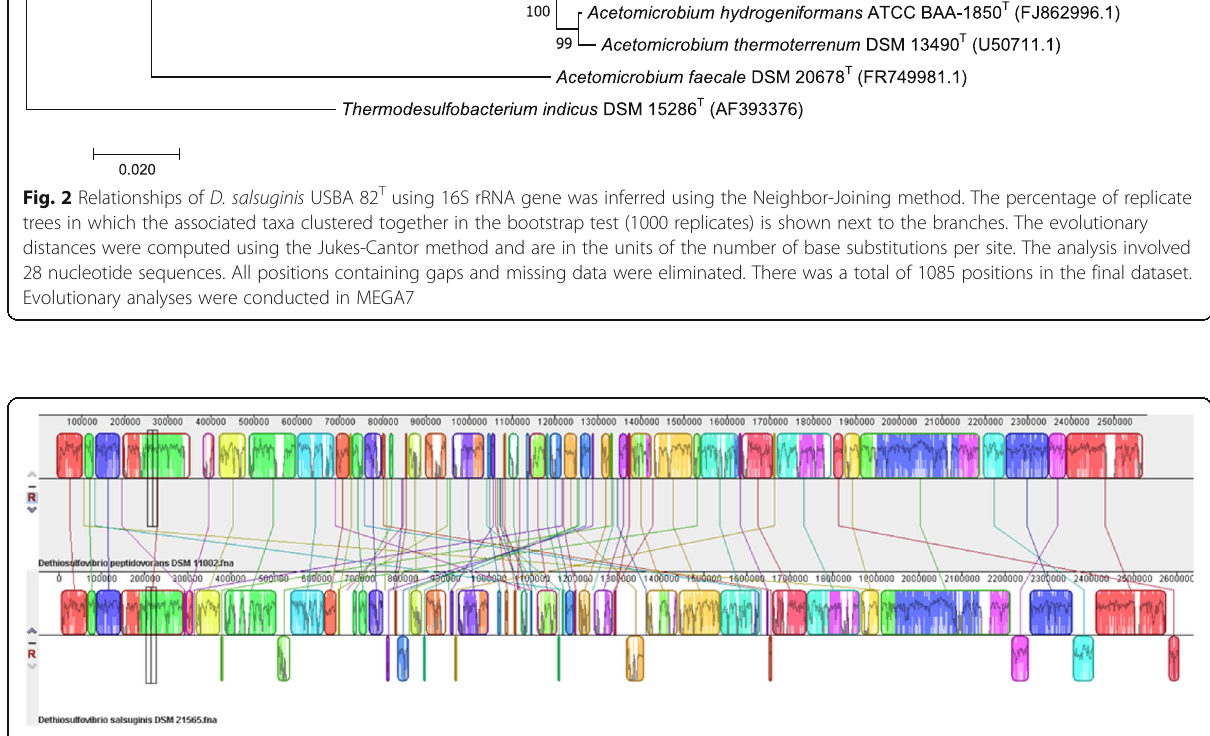
Fig. 3 Multiple Alignment performed using Mauve of D. salsuginis USBA-82 T and D. peptidovorans DSM 11002 T genomes. The type strain of D. peptidovorans (DSM 11002 T ) is shown at the botton and the strain USBA-82 T (DSMZ 21565 T ) is shown in the top. Conserved blocks are represented with direct lines from D. peptidovorans to strain USBA-82 T showing synteny of genes among the